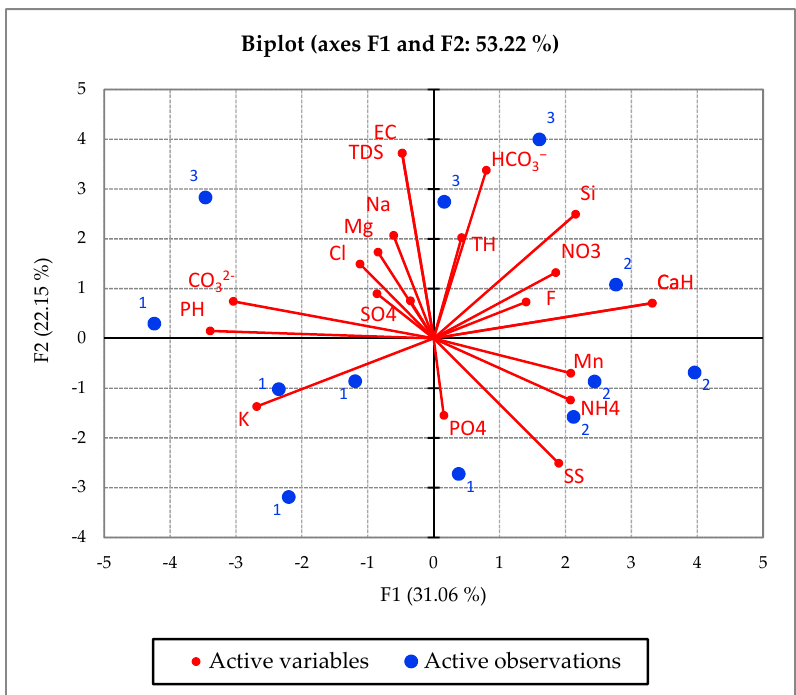
Figure 11. Result for biplot diagram for three clusters in the study area.